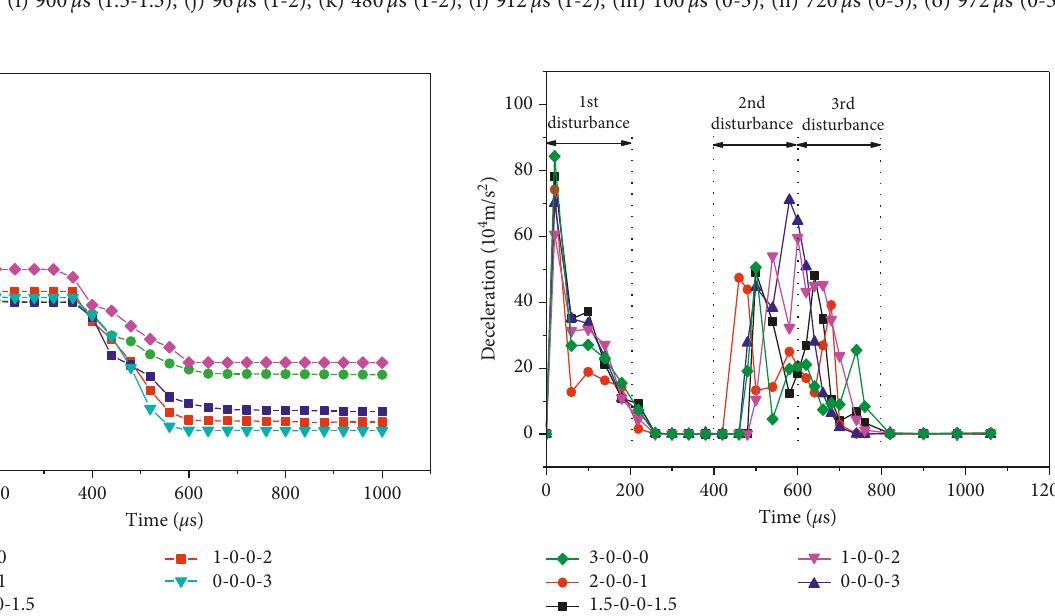
Figure 17: Deceleration-time curves of projectile perforating segmented targets with different steel liner